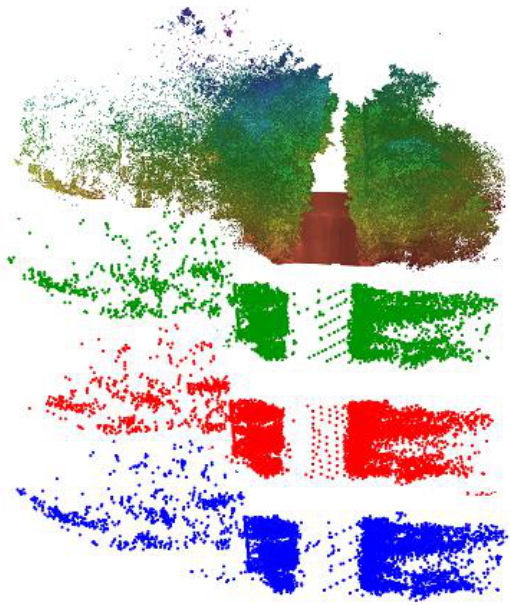
Figure 12. Height vegetation